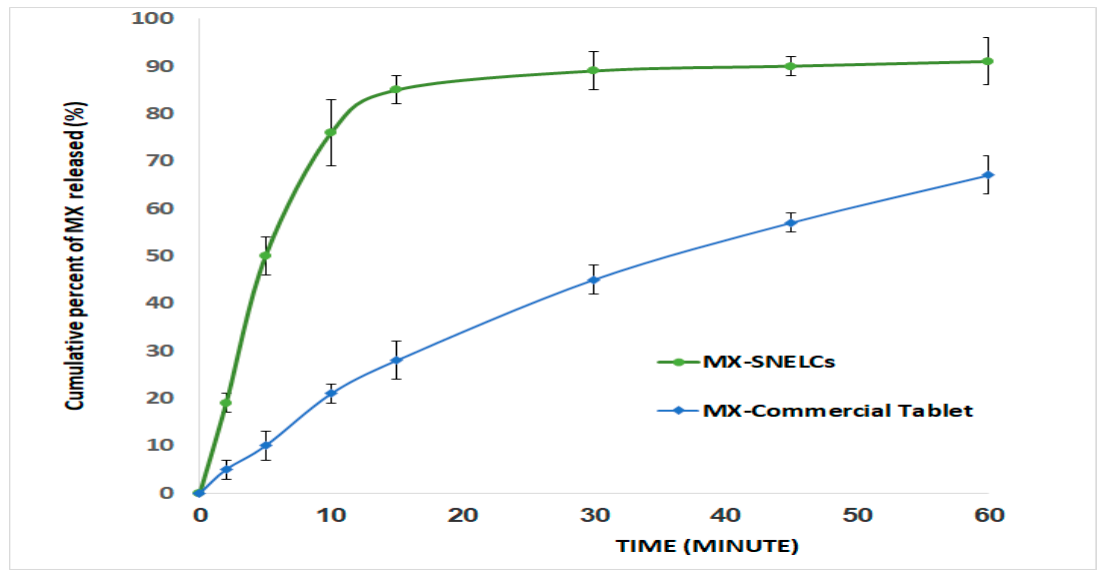
Figure 4. In vitro drug release profiles of lyophilized composite loaded with Meloxicam SNEDDS prepared with peppermint oil (MX-SNELCs) and marketed composite of Meloxicam (MX commercial tablets).